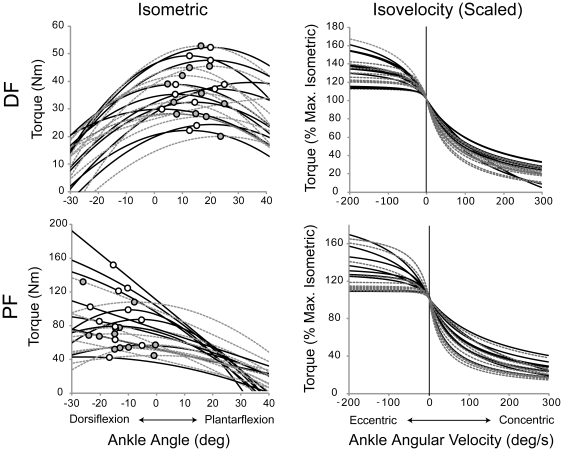
Equations representing the best fit between the experimental data and second order polynomials (torque-angle relation; isometric) and rectangular hyperbolas (torque-angular velocity relation; isovelocity) for young (solid black lines) and older (dashed gray lines).The solid circles positioned on the isometric curves represent the peak isometric torque. For some subjects, the peak did not occur within the subject's range of motion, in these cases the solid circle is positioned at the end of the range of motion. The isovelocity fits are scaled to the peak isometric torques.